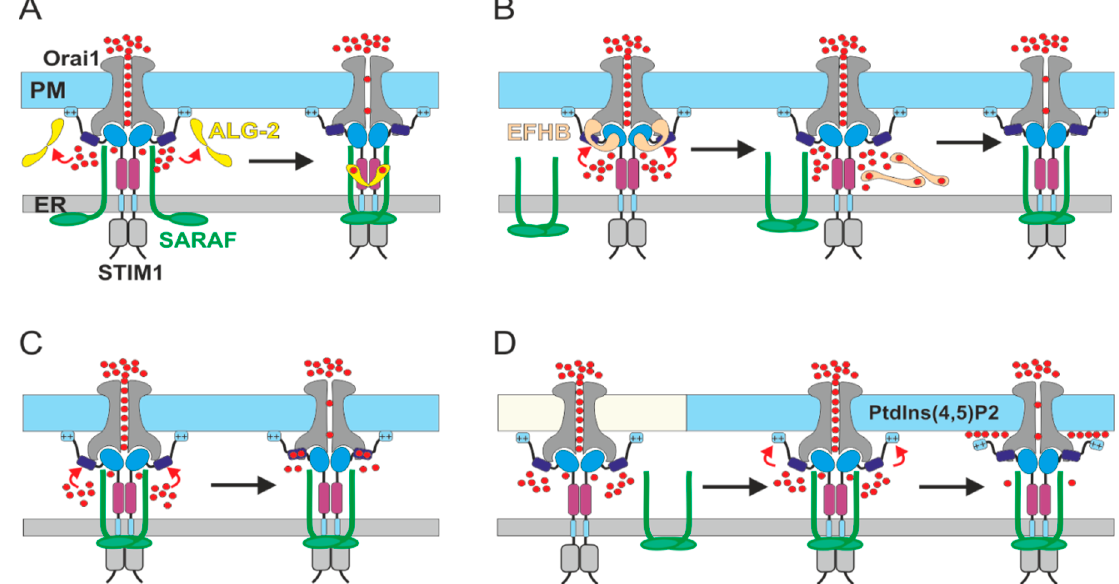
Figure 2. Models for SCDI by SARAF. Rectangle and oval symbols indicate the different domains of STIM1 as in Figure 1. ( A ) Ca 2+ -dependent interaction between ALG-2 (yellow) and SARAF (green) promotes channel inactivation via stabilization of SARAF dimers. ( B ) EFHB (brown) binds to the STIM1-Orai1 channel complex. Increase in Ca 2+ causes disassociation of EFHB from STIM1. Subsequent binding of SARAF to STIM1 promotes channel inactivation. ( C ) Binding of Ca 2+ to the STIM1 ID induces persistent channel inactivation when SARAF interacts with STIM1. ( D ) Binding of SARAF to STIM1 facilitates translocation of the channel complex from PM microdomains poor with PtdIns(4,5)P2 (off-white) to domains enriched with PtdIns(4,5)P2 (cyan). Local increase in Ca 2+ promotes channel inactivation by remodeling the interaction of STIM1 with the PM.